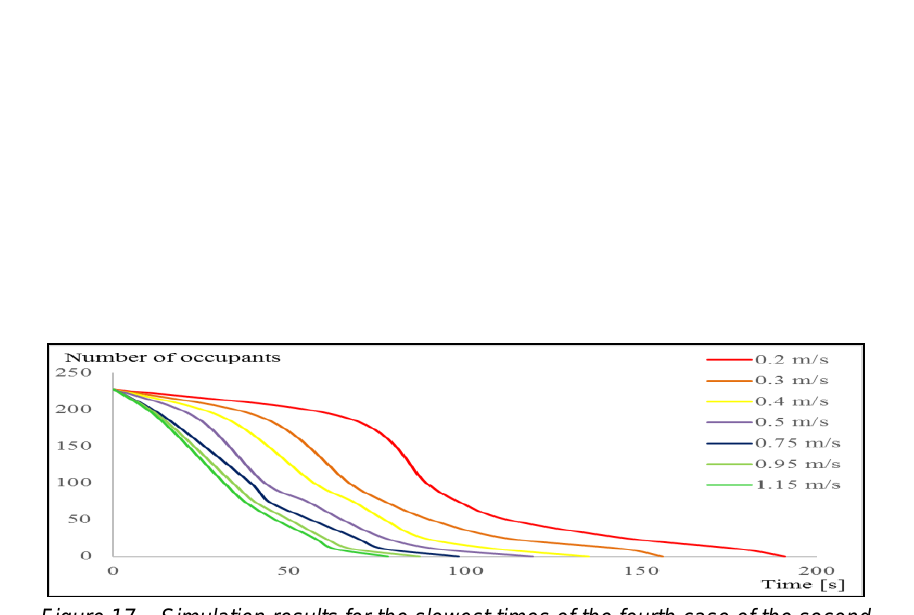
Figure 17 – Simulation results for the slowest times of the fourth case of the second scenario